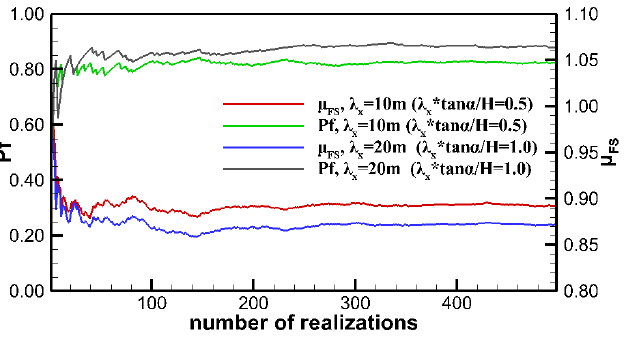
Figure 9. Pf and µ FS , when λ y = 1 m and λ x = 10 m and 20 m, respectively, as functions of the number of